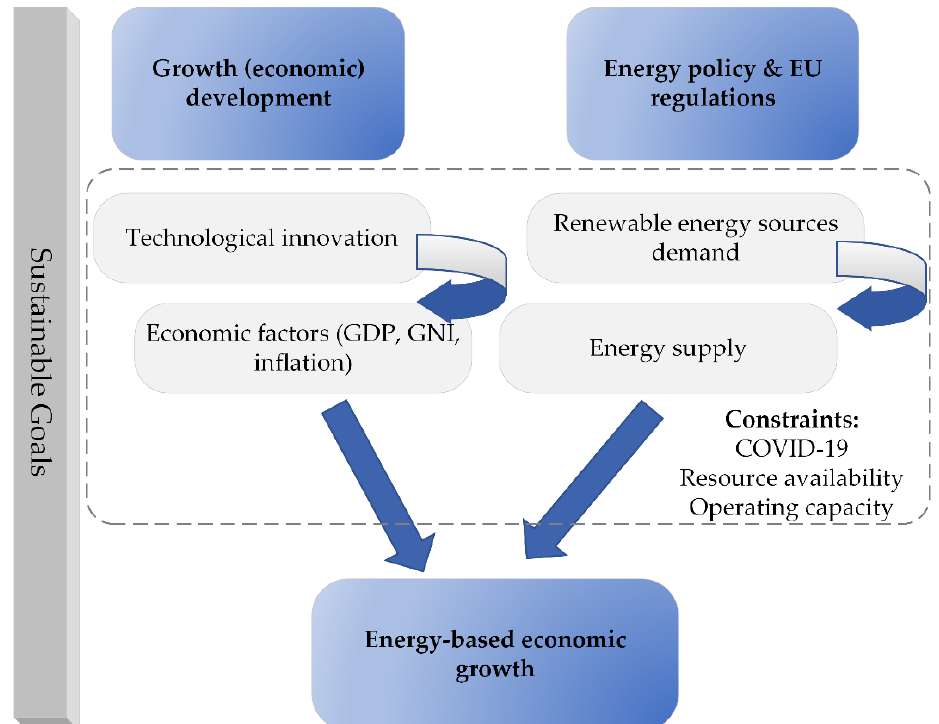
Figure 1. Energy-based economic growth. Source: Own elaboration.